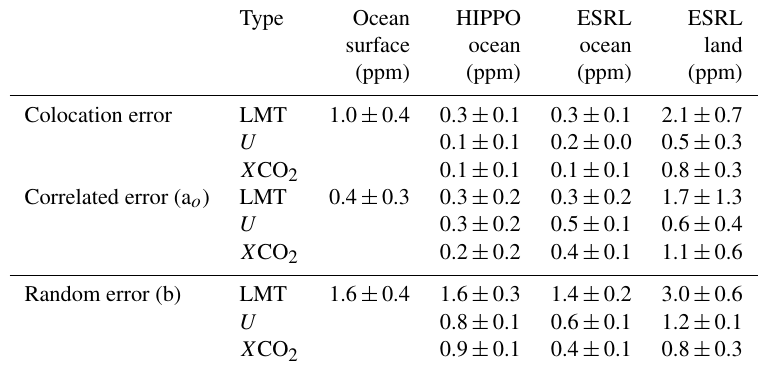
Table 6. Estimated colocation, correlated, and random errors using Eq. (12). The colocation errors are taken from Table